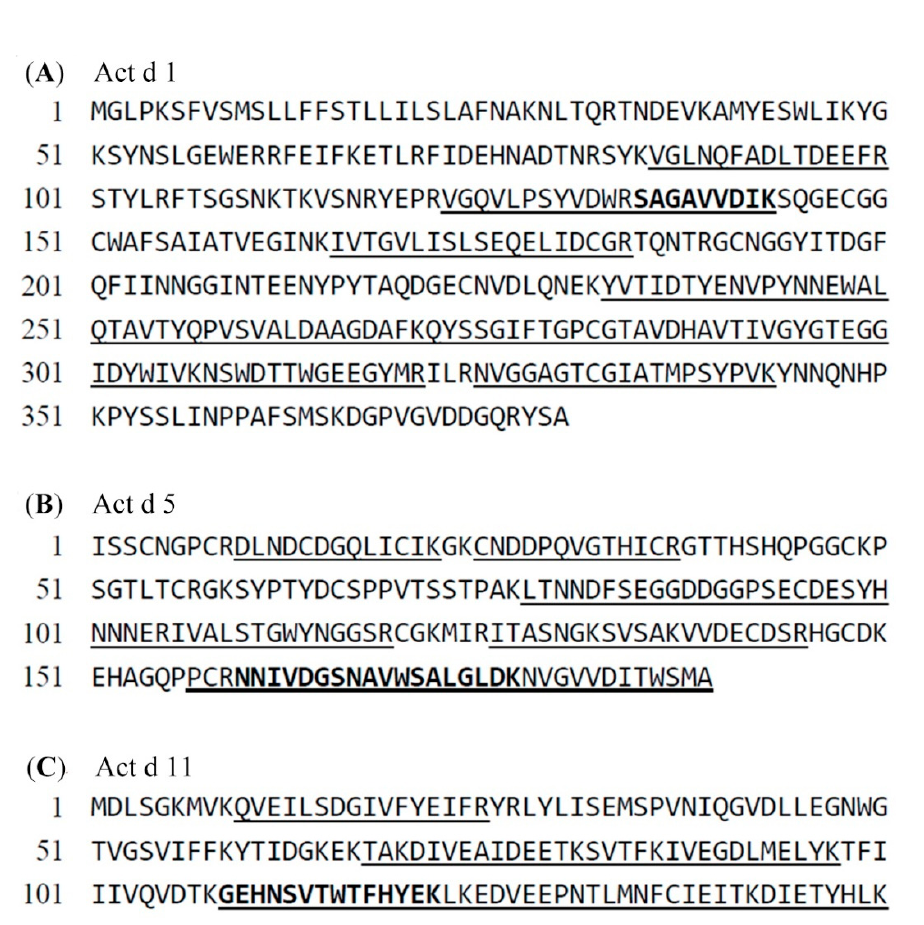
Figure 3. Protein sequences of ( A ) actinidin (Act d 1), ( B ) kiwellin (Act d 5), and ( C ) kirola (Act d 11). The tryptic peptides identified with LC / ESI-Q-ToF are underlined, and the selected signature peptides are presented in boldface type.